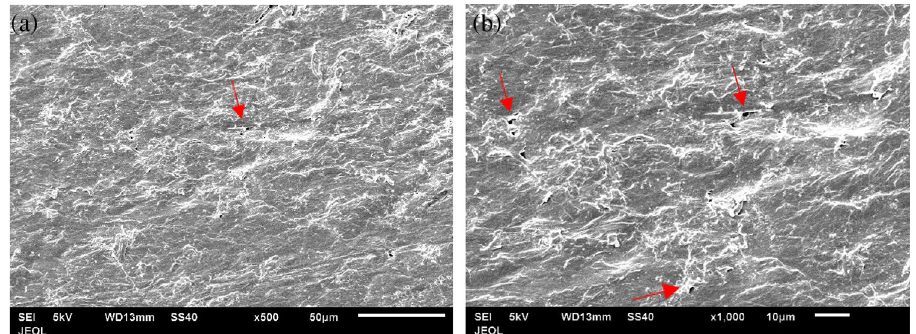
Figure 12. Magnified surface morphology of a composite (melted) of sample number 7 showing a very few pores marked by arrows, ( a ) at × 500 and ( b ) at × 1000.